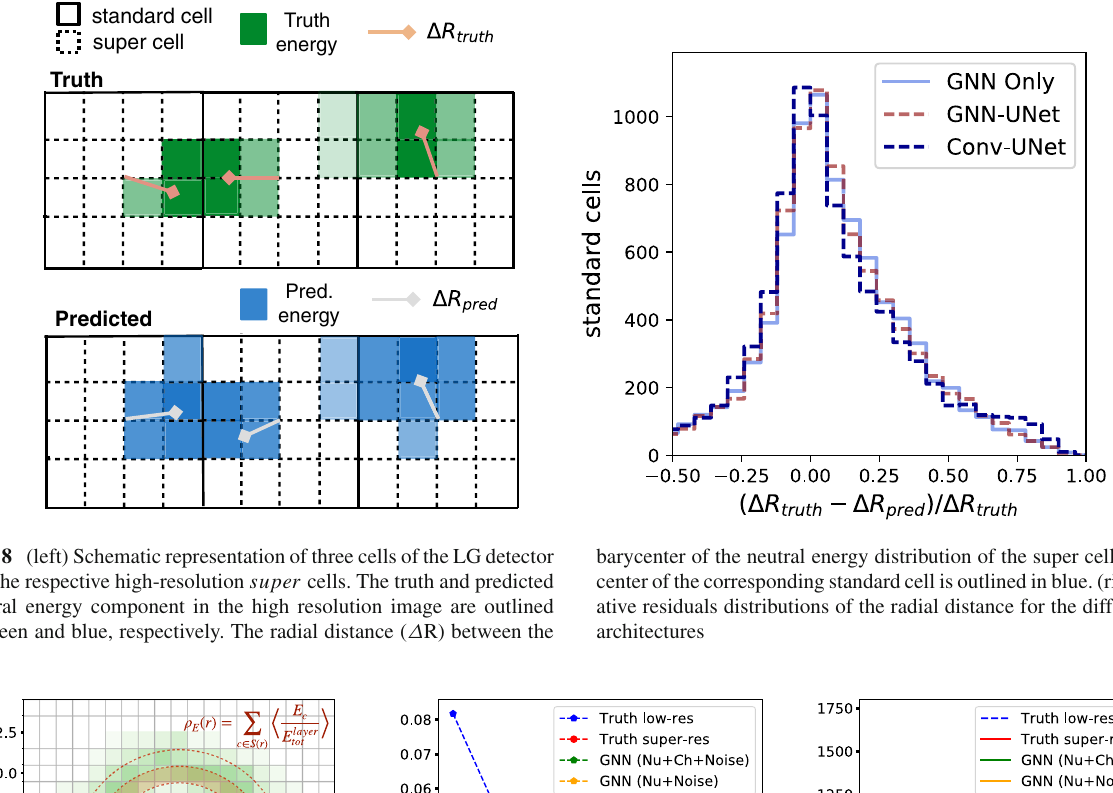
green curve is the prediction when there is charged and neutral energy overlapping along with noise. The orange curve, which follows closely the truth distribution, shows the prediction when a training and eval- uation is carried out on sample consisting of neutral energy and noise only. This demonstrates the degradation originates from the presence of overlapping charged shower. All predictions are computed from the GNN algorithm. The other approaches considered herein give similar